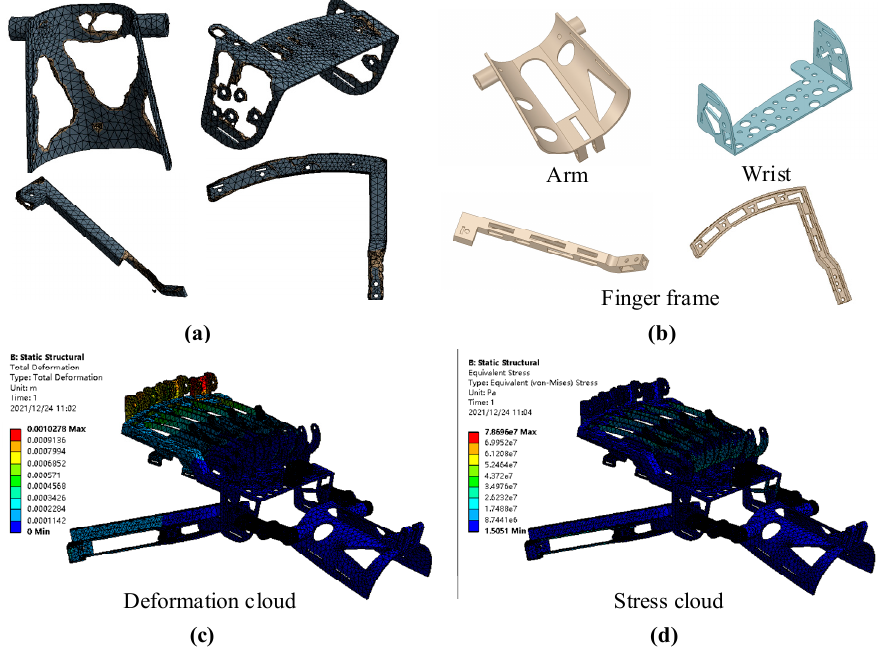
Figure 12. ( a ) Topology optimization output results; ( b ) edit the output model and convert it into a solid model; ( c ) deformation cloud after topology optimization; ( d ) stress cloud after topology optimization.